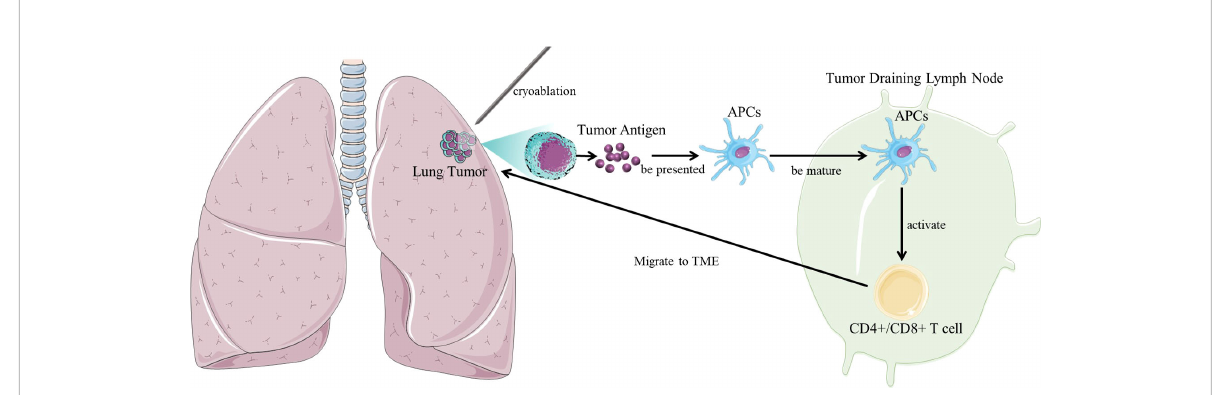
FIGURE 1 The interaction between tumor and immune system in cryoablation. In the mechanism of cryoimmunotherapy, frozen tumor cells release tumor antigens, which are taken up by immature myeloid dendritic cells (DCs). In the case of necrotic cell death following cryoablation, dendritic cells mature and migrate to tumor-draining lymph nodes (TDLNs), where they activate tumor-speci fi c T cells and then migrate back to the tumor site. Achieve the synergistic effect of enhancing the body ’ s own immune